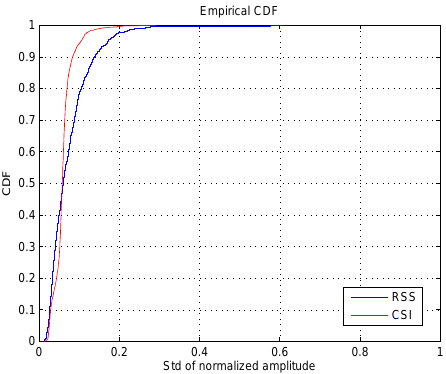
Figure 5. Cumulative distribution function (CDF) of the standard deviations of CSI amplitudes and Received Signal Strength (RSS) values at 25 different locations of more than 2500 received